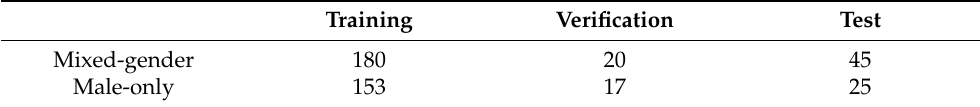
Table 4. Number of records used for training, validation, and testing.